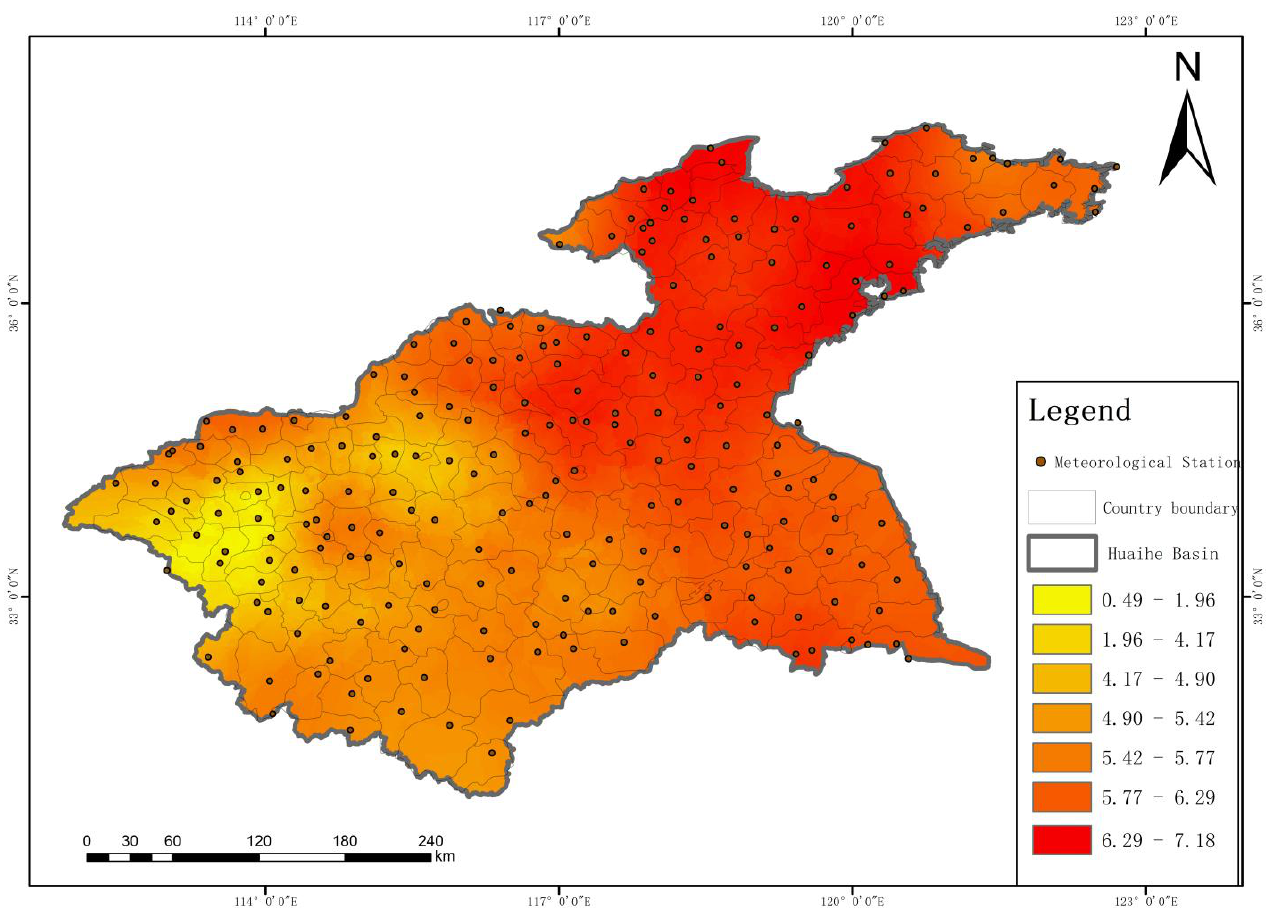
Figure 3. Spatial distribution of Z-values of annual mean temperature.